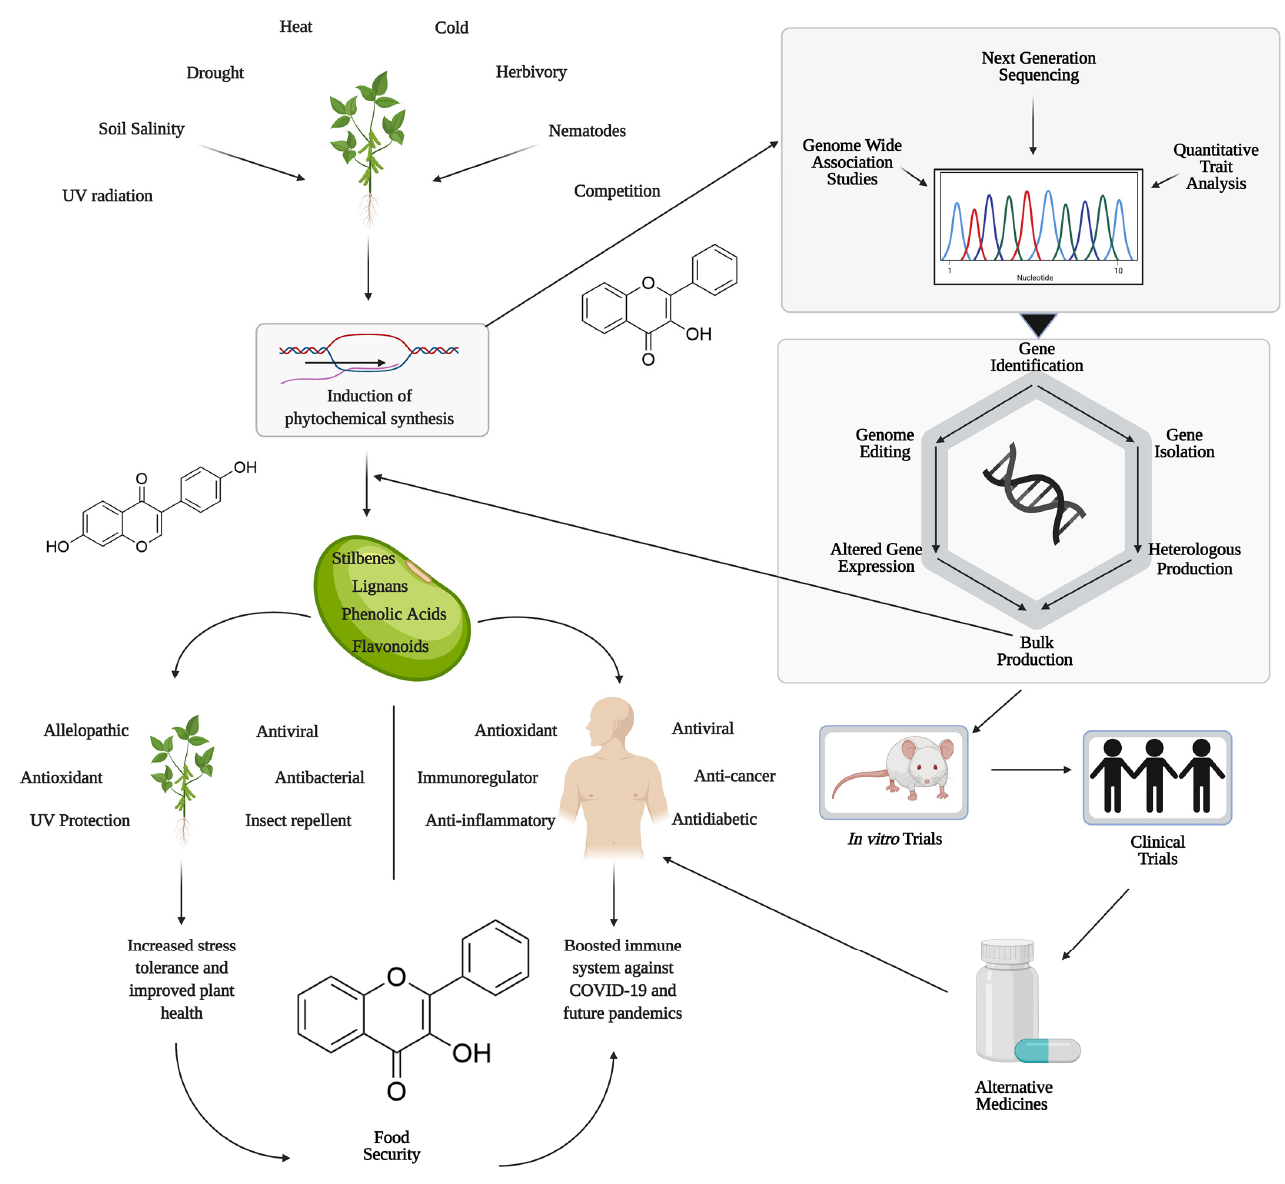
Figure 1. A schematic representation of polyphenols in both plant chemical defense and human health and how modern technologies can be utilized to enhance production of these compounds (Created with BioRender.com).